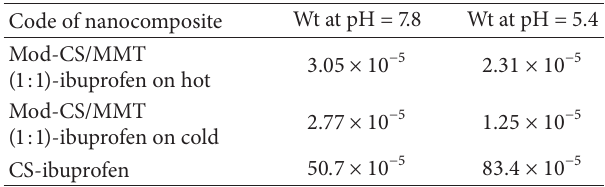
mod-CS shows bands at 1740 and 1615 cm −1 corresponding to C=O stretching vibration and NH–, respectively. The bands